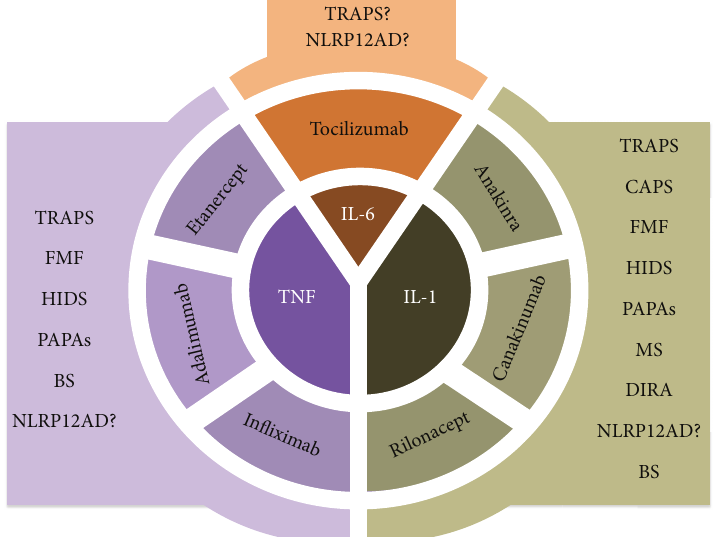
Figure 2: Schematic representation of the biologic agents used in the management of monogenic autoinflammatory disorders. FMF: familial Mediterranean fever; TRAPS: tumor necrosis factor receptor-associated periodic syndrome; CAPS: Cryopyrin-associated periodic syndromes; MKD: mevalonate kinase deficiency syndrome; NLRP12AD: NLRP12-associated autoinflammatory disorder; BS: Blau syndrome; MS: Majeed syndrome; PAPAs: pyogenic arthritis, pyoderma gangrenosum and acne syndrome; DIRA: deficiency of interleukin-1 receptor